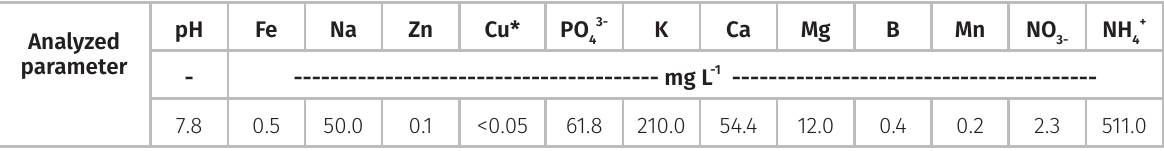
Table II. Chemical characterization of swine production wastewater used to irrigate corn crops. Analyzed